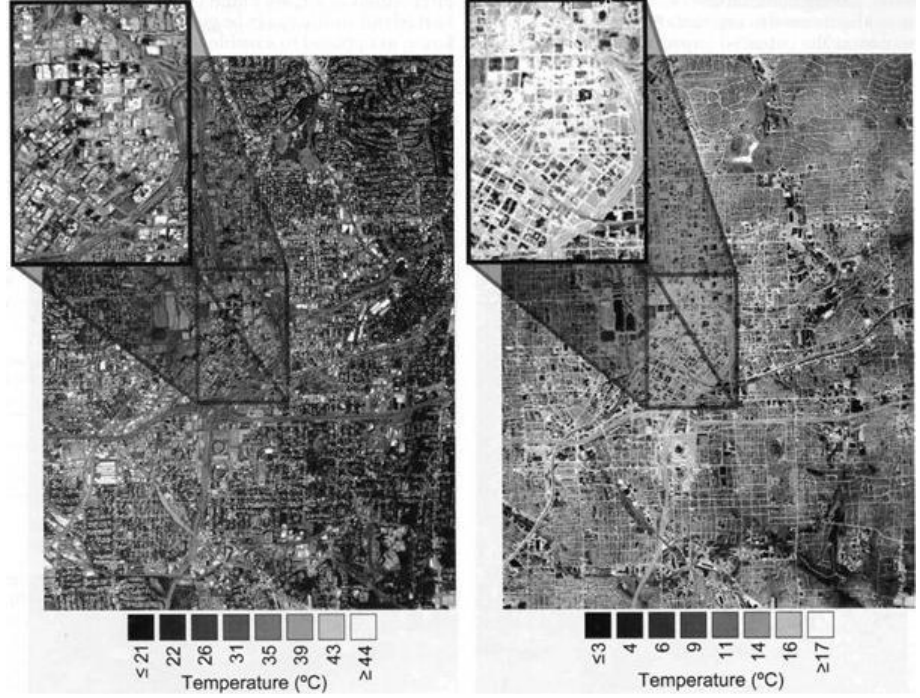
Figure 3. Daytime and nighttime airborne thermal infrared data collected at 10 m spatial resolution for the Atlanta, GA central business district. The high spatial resolution of these data permits the quantification of thermal responses from individual surfaces, including rooftops